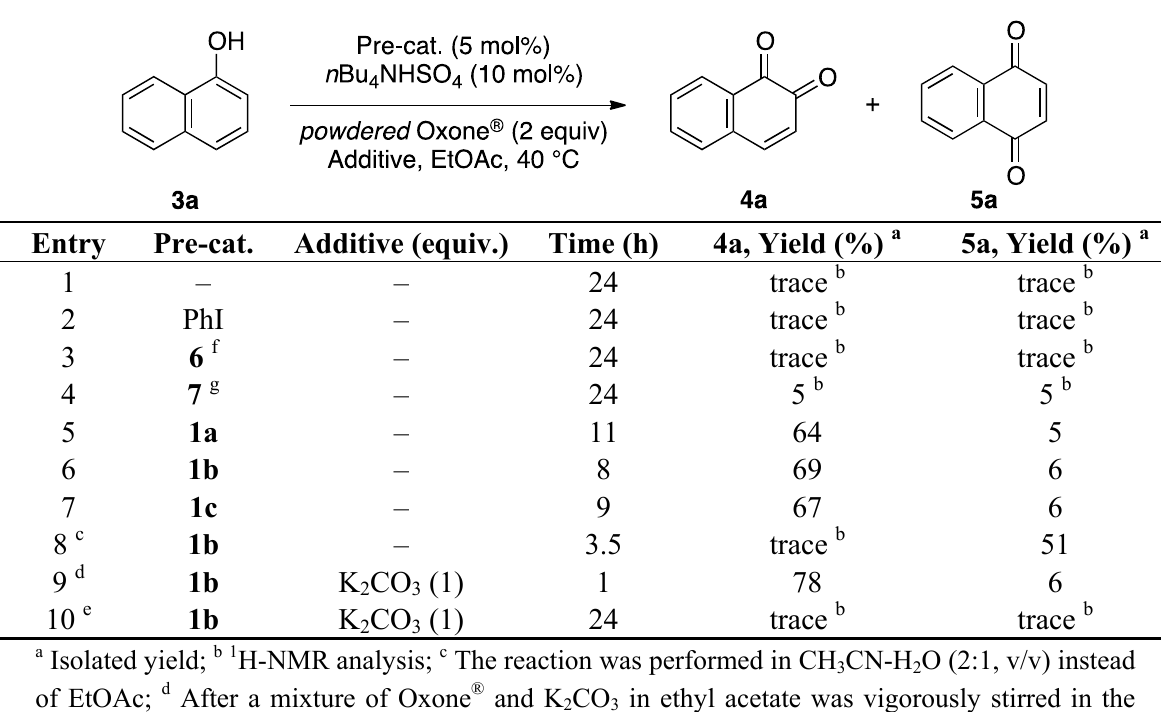
Table 1. Hypervalent iodine-catalyzed oxidation of 1-naphthol 3a